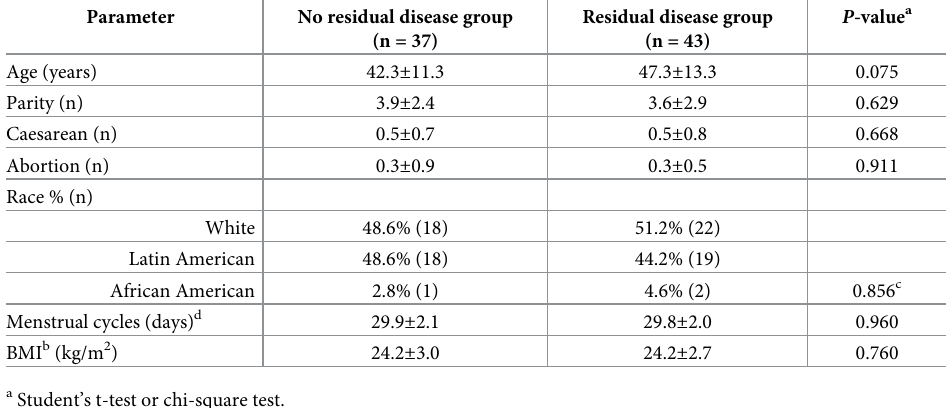
Table 1. Analysis of the demographic and clinical characteristics as possible risk factors for the presence of resid- ual disease in the hysterectomy specimens of women after conization for CIN 2/3 with endocervical cone margin involvement (mean ±